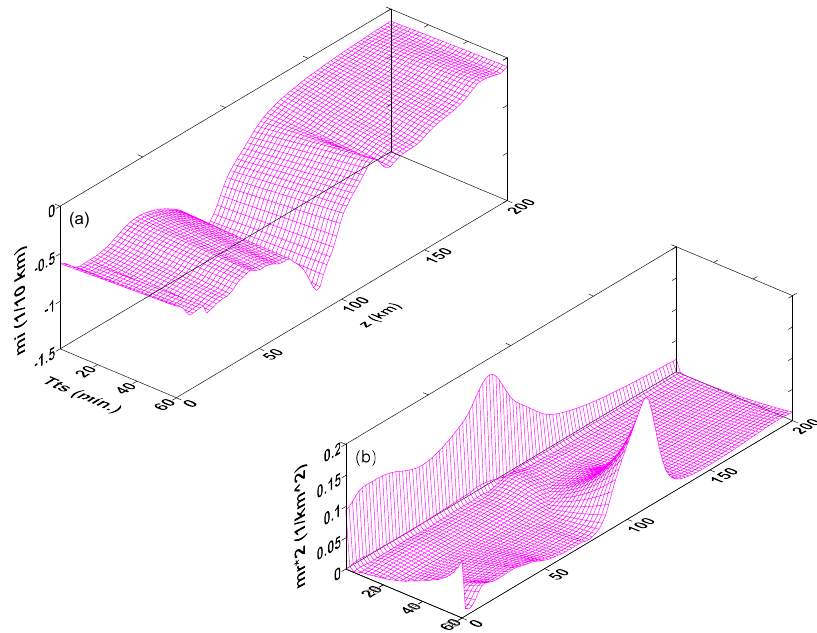
Figure 5. Imaginary and squared real vertical wavenumbers, m i (1/10 km) and m 2 r (1/km 2 ), in Case 5 of IAG waves under non-isothermal and wind shear conditions. ( a ) m i -envelop; and ( b ) m 2 r -envelop. Note that due to the negligible f -effect, (a) gives the pink band in Figure 3; while (b) has no difference from (d) in Figure